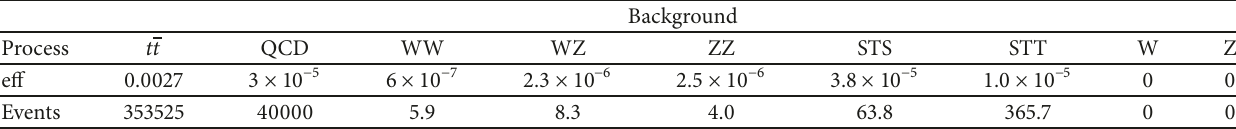
Table 4: Background selection efficiencies and number of events at tan 𝛽 = 0.5 before the mass window cut. The QCD sample is the 6-jet final state and STS (STT) denote the single top 𝑠 -( 𝑡 -) channel.